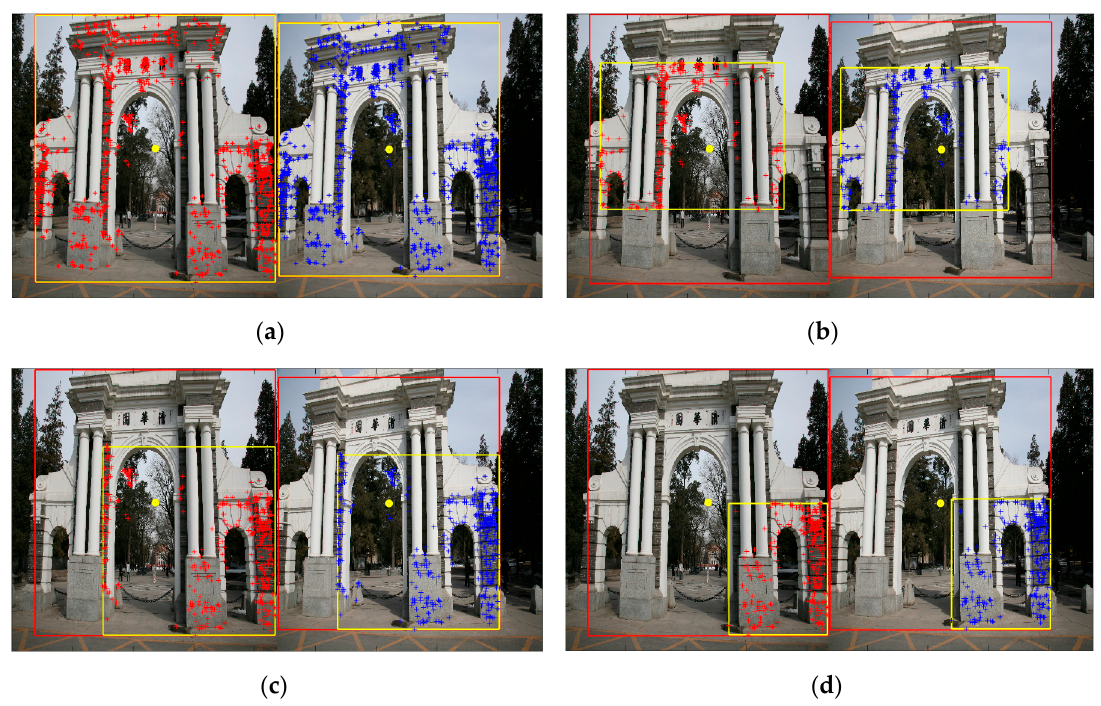
Figure 8. Matching points with different distribution patterns. ( a ) Throughout the entire overlapping region. ( b ) Surrounding the center point of overlapping regions. With different distributed scopes in ( c ) and ( d ) surrounding the lower-right corner of overlapping regions.